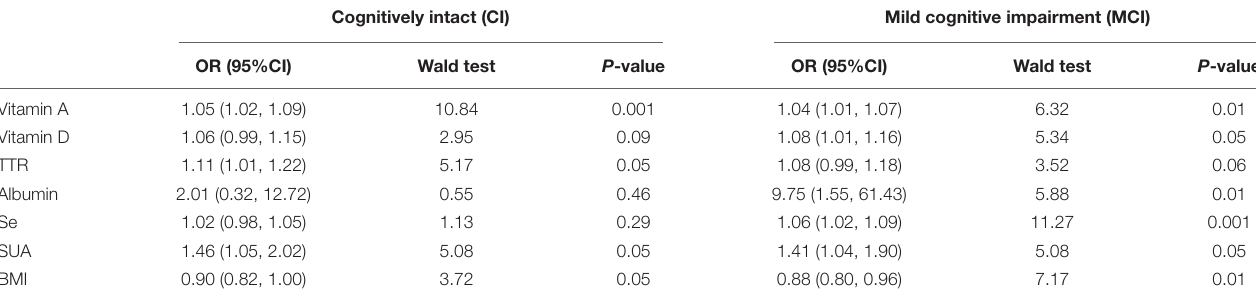
TABLE 4 | Multinomial logistic regression